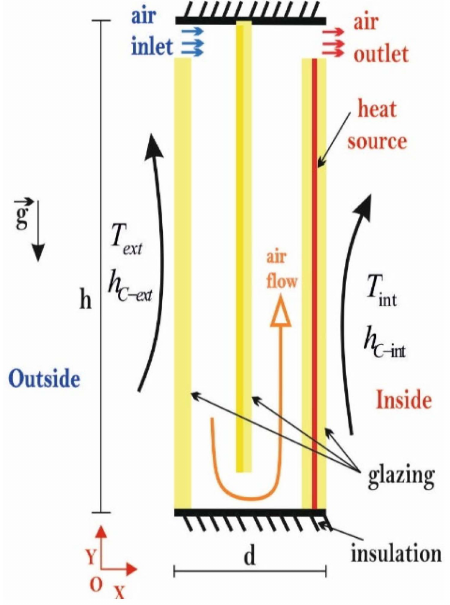
Figure 4. Physical model of the heating